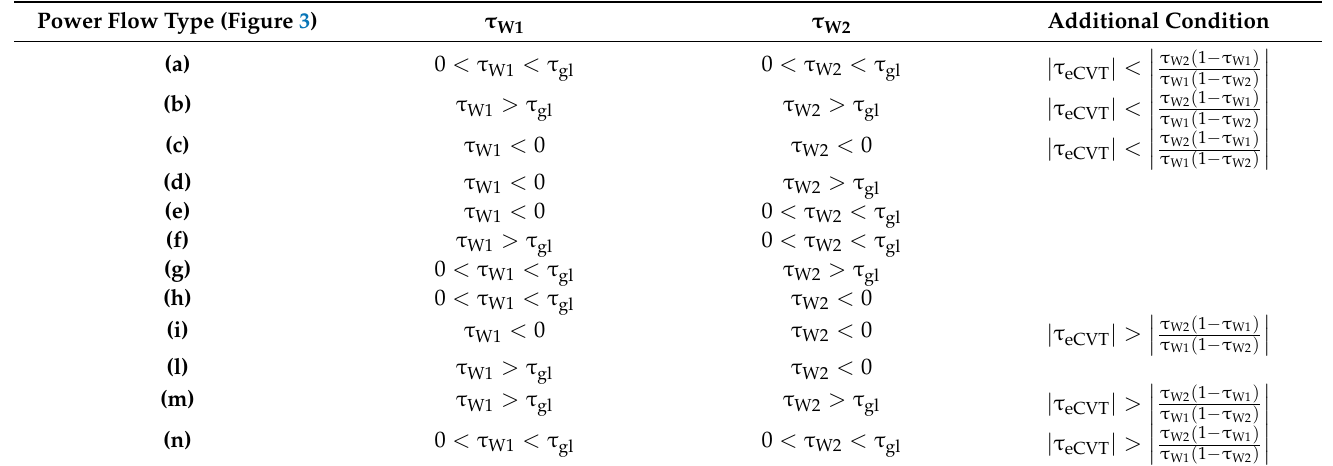
Table 3. Case 1—Conditions for each power flow.